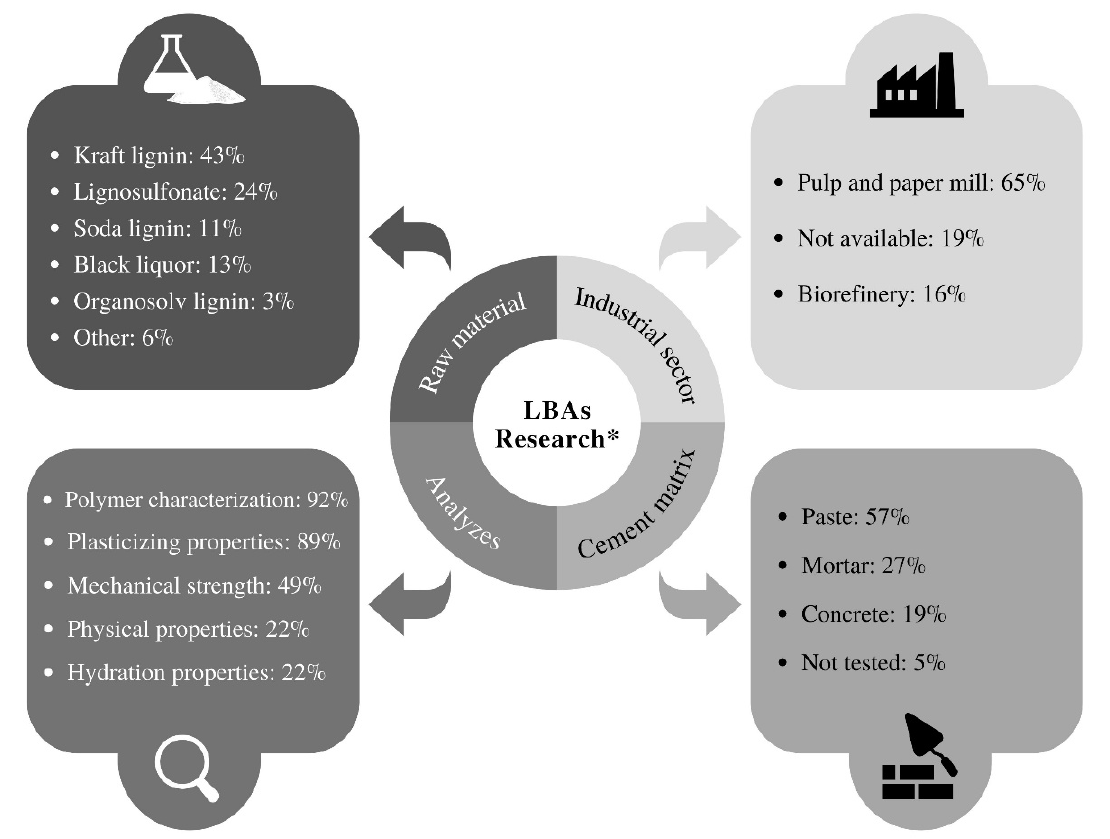
Figure 8. Comparative profile of the content of articles on LBAs (* The data indicate the frequency with which the parameters were adopted in the selected articles).